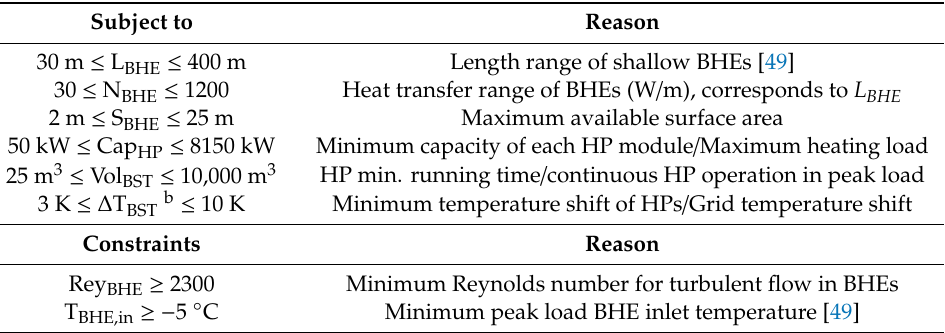
Table 4. Ranges of optimization variables and constraints.